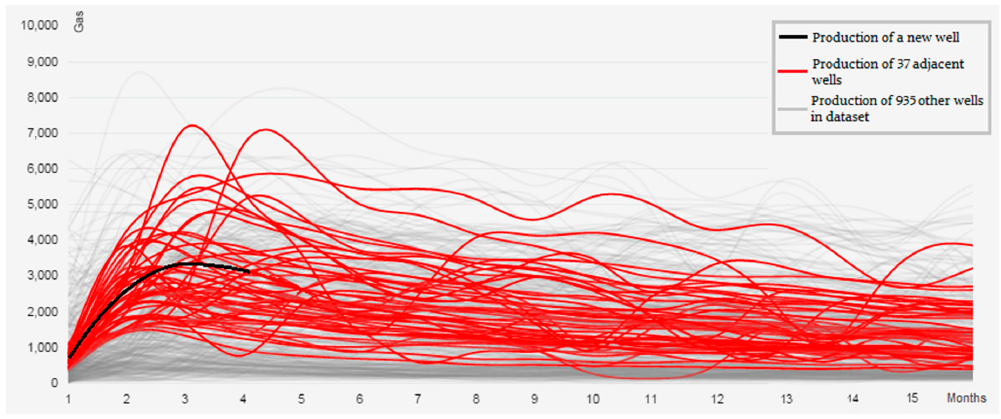
Figure 11. Production data of a new well relative to existing adjacent wells.